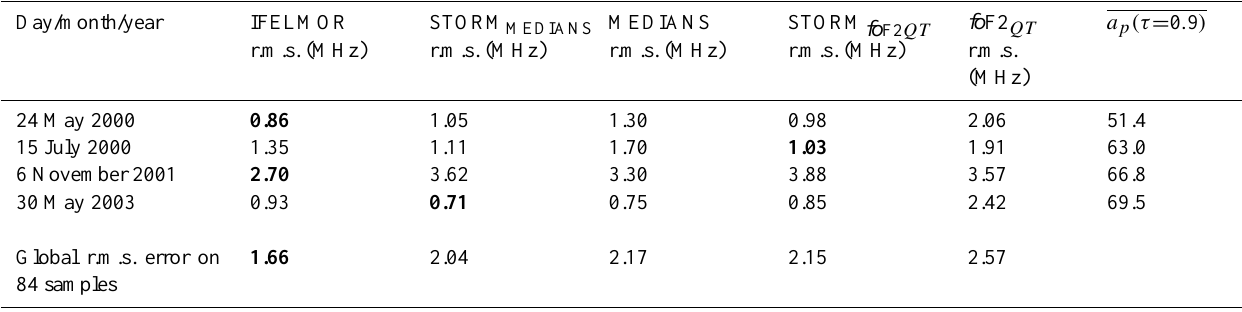
Table 4. Comparisons in terms of r.m.s. for the days selected under disturbed ionospheric conditions with 50 <a p (τ = 0 . 9 ) ≤ 70; the best performance is labelled in bold.